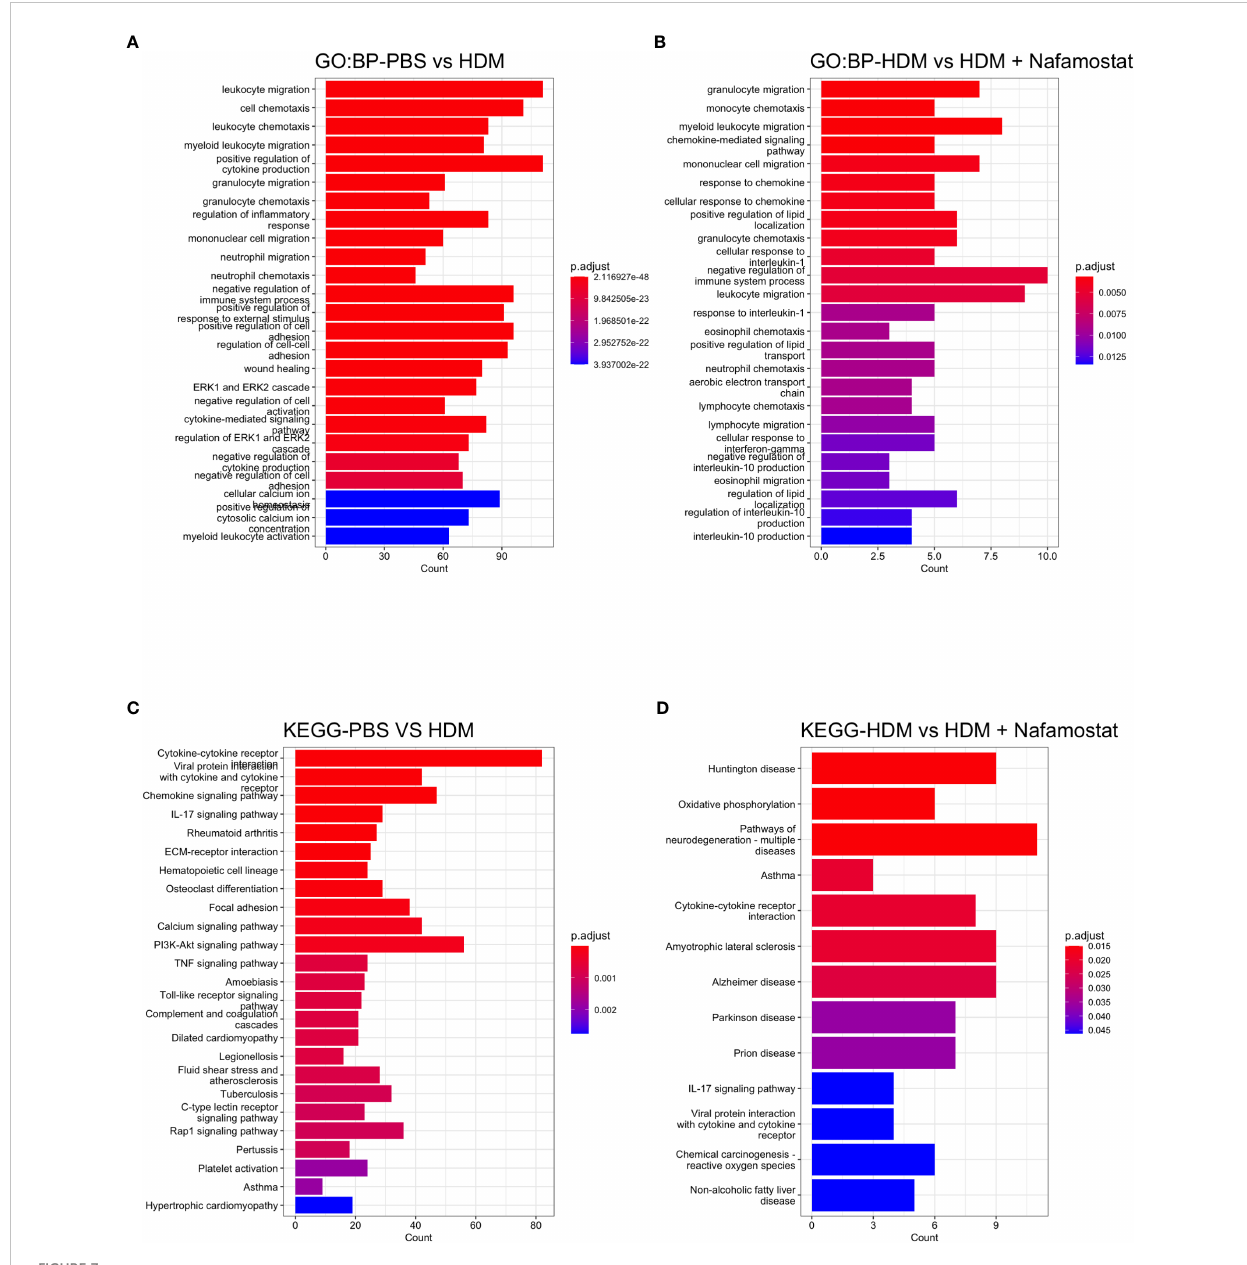
FIGURE 7 Overview gene enrichment analysis outlining the effect of nafamostat on HDM-induced features of asthma. The top 25 biological process (BP) (A, B) and the associated KEGG pathways (C, D) of the DEGs between the control- (PBS) vs. HDM and the HDM vs. HDM + nafamostat (20 mg/kg) groups were analysed using the enrichGO and enrichKEGG functions. The output of the analyses was visualized using bar plot function in clusterPro fi ler. For each plot, the x-axis represents the enriched gene counts and the y-axis represents a signi fi cant GO de fi nition/KEGG pathway, respectively. n = 3 – 4 mice per group. HDM, house dust